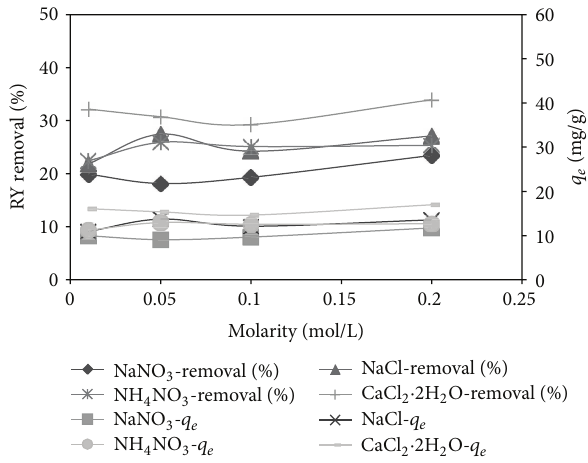
Figure 7: The electrolyte effects on dye removal efficiency and adsorption capacity of SSCAC for Remazol Yellow adsorption (adsorbent dosage: 0.1g/50 mL, initial dye concentration: 100mg/L, pH: